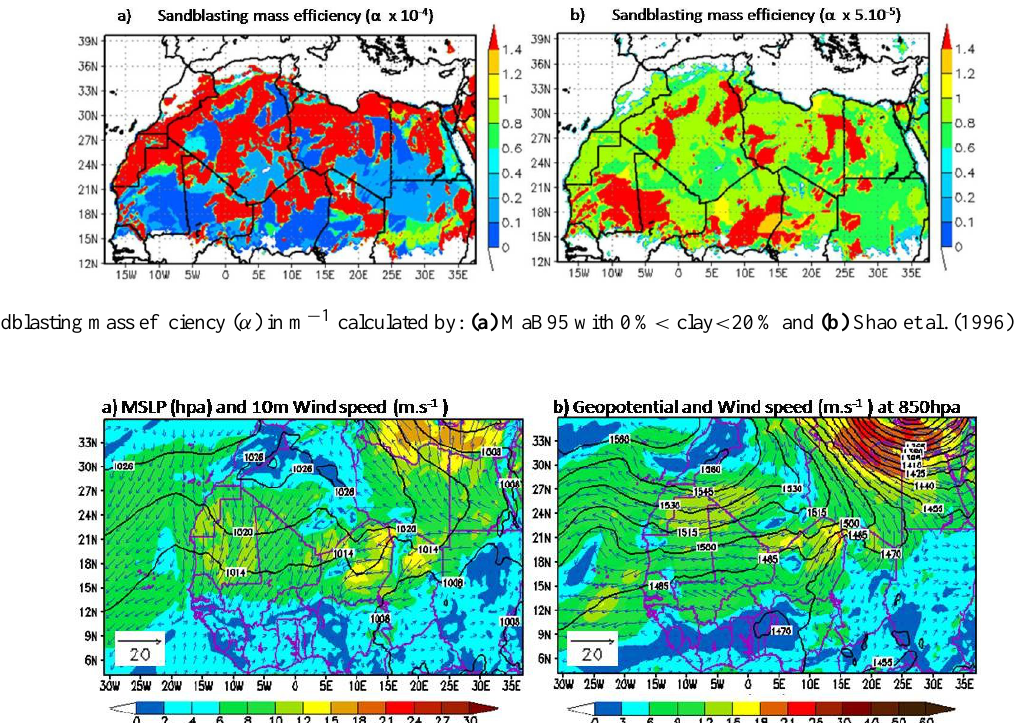
Fig. 10. Mean sea level pressure (hPa) and wind speed at 10m (a) and geopotential (in metres) and wind speed at 850hPa (b) , on 8 March 2006 at 12:00 UTC.